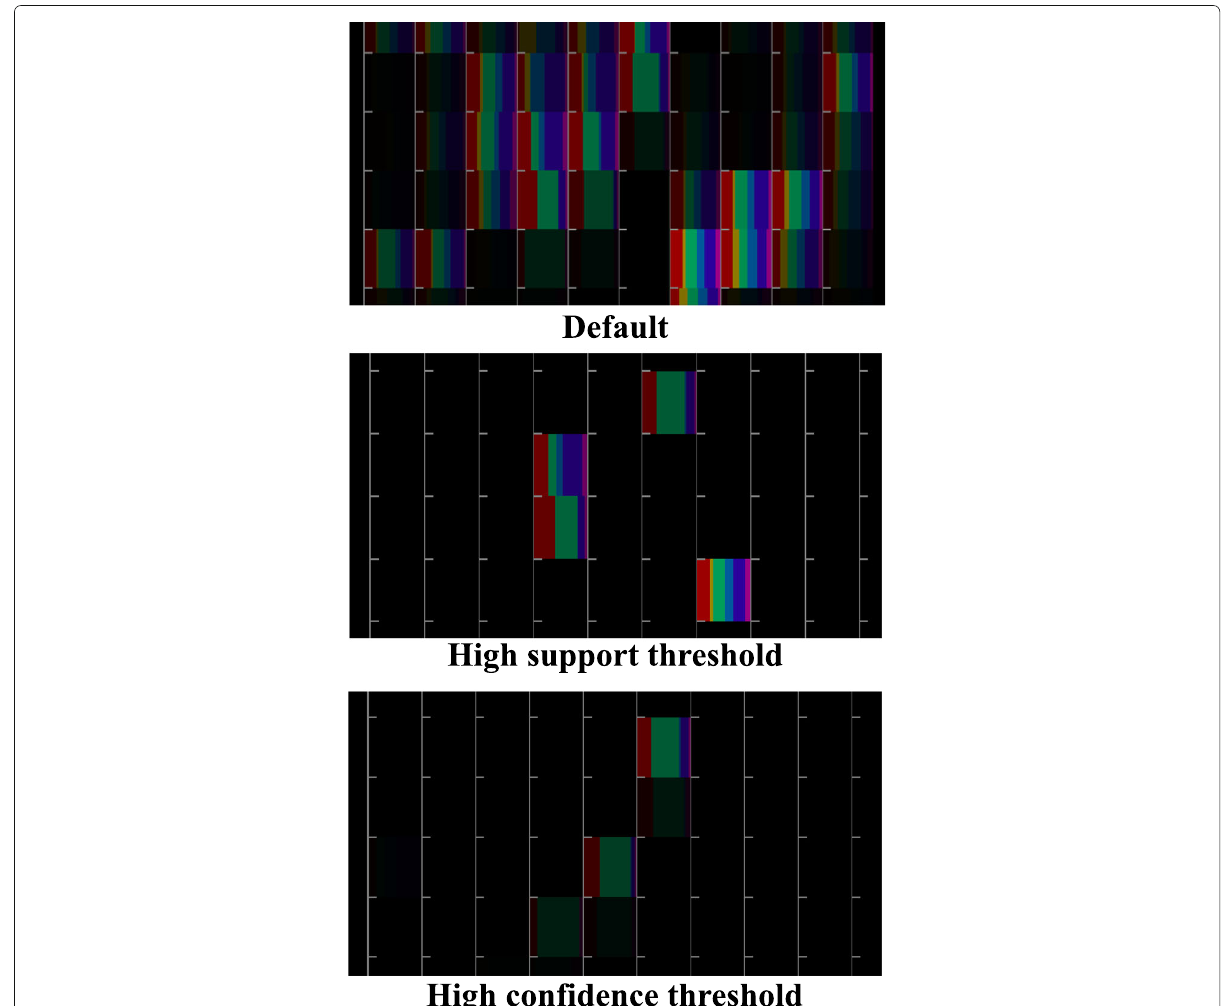
Fig. 6 Threshold adjustment of association rule by using slider